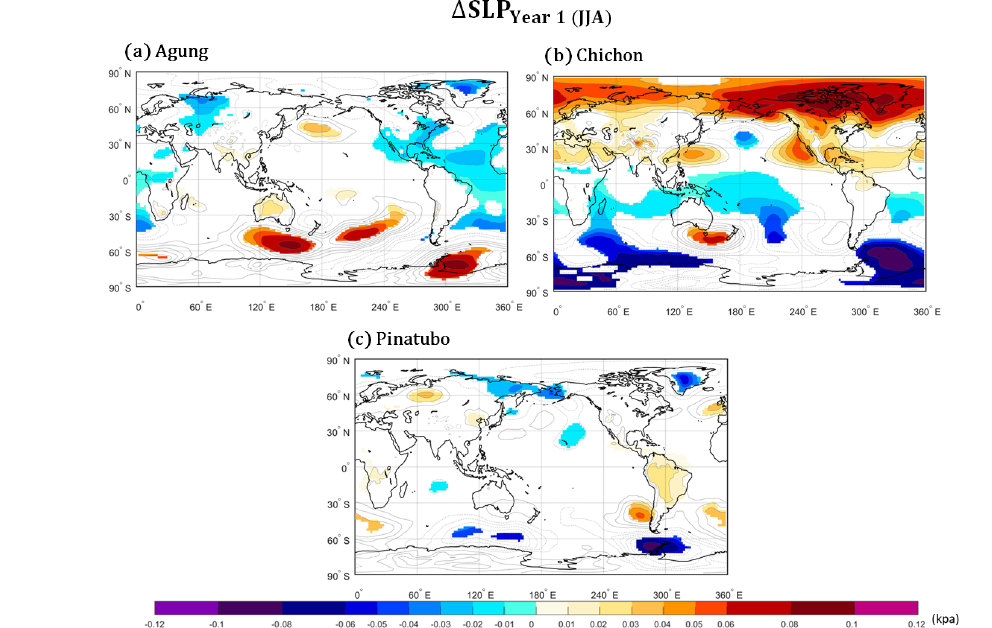
Figure A10. Ensemble average of change in the sea level pressure between the climatology and the volcano case for the first summer after the Agung (a) , El Chichón (b) and Pinatubo (c) eruptions. Only significant anomalies are shown with an approximate 95% confidence level using Student’s t test. Contours show SLP anomalies following the colour bar scale (solid line for positive anomalies and dashed line for negative